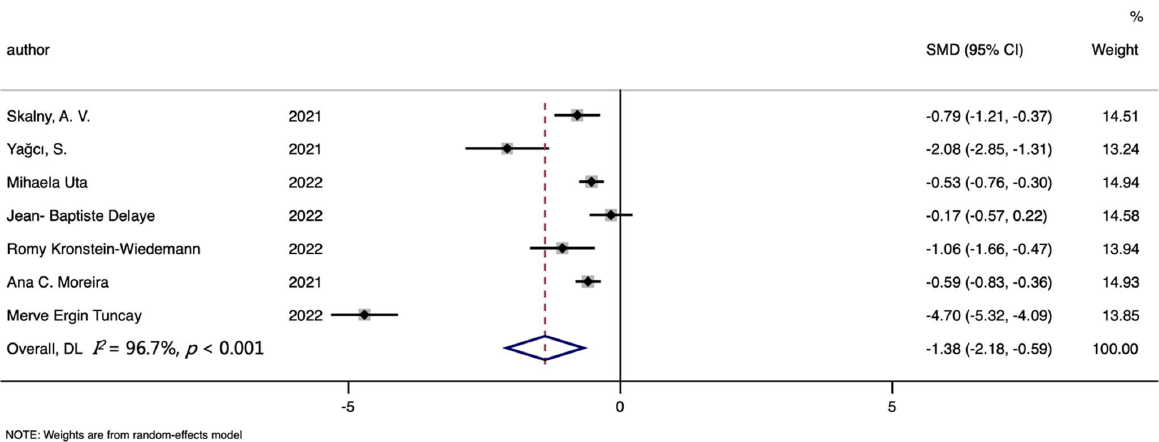
Figure 5. Forest plot of standard mean difference (SMD) with corresponding 95% confidence intervals (CIs) of studies [10,16–21] on serum iron levels in COVID-19 cases and controls. The solid diamond and horizontal line represent the study-specific effect and 95%CI, respectively; the size of the grey square is positively correlated with the weight distributed to each study in the meta-analysis. The center of open diamond with the vertical dashed line expresses the pooled SMD, and the width expresses the pooled